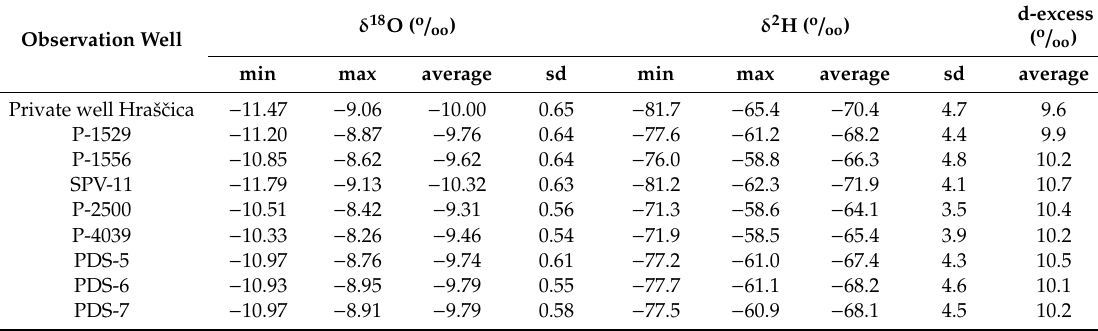
Table 7. Minimum, maximum, and averaged isotopic composition of the groundwater by sampled well. Observation Well